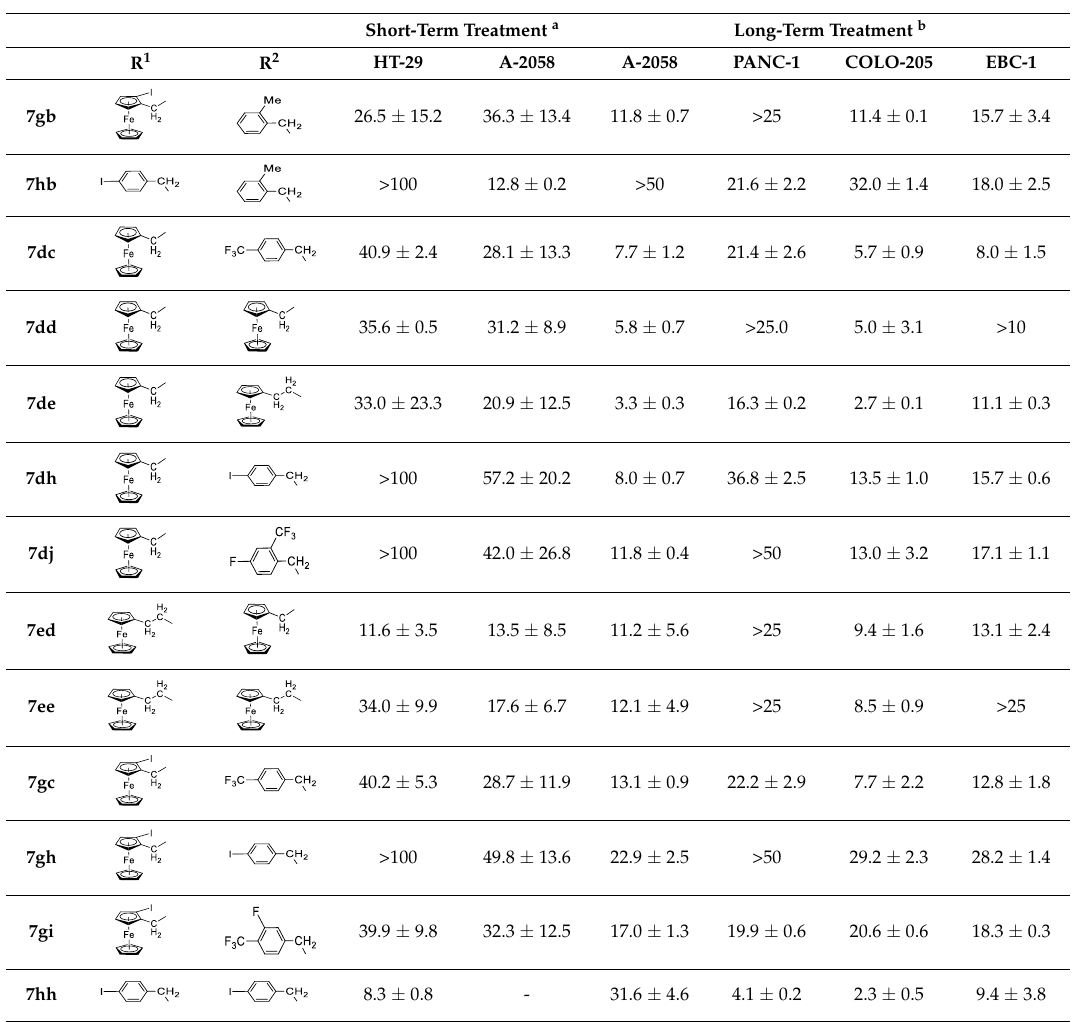
Table 1. In vitro cytotoxic effect of compounds 7ab , 7ac , and novel impiridones on various cell lines characterised by half maximal inhibitory concentration (IC 50 ) ± Standard Deviation (SD) values.